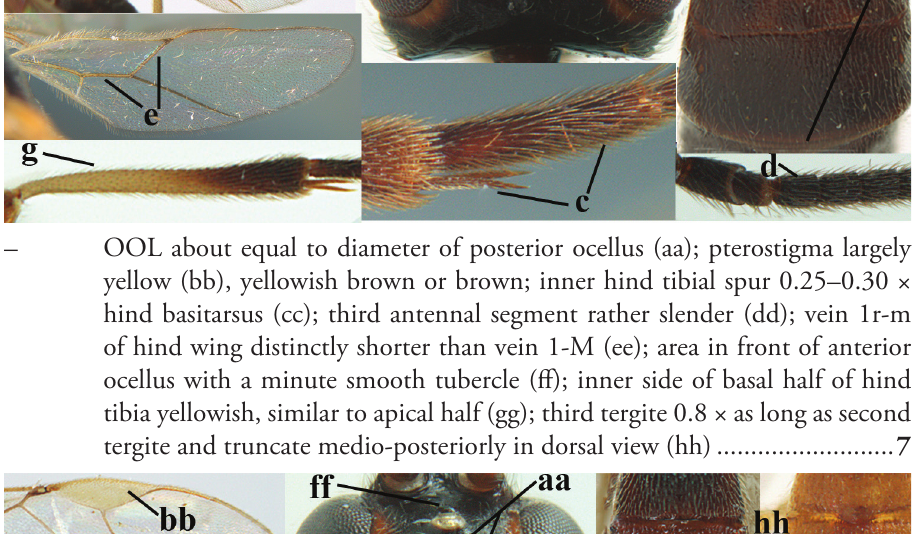
OOL 0.4–0.5 × diameter of posterior ocellus (a); pterostigma dark brown (b); inner hind tibial spur 0.40–0.50 × hind basitarsus (c); third antennal segment robust (d); vein 1r-m of hind wing about as long as vein 1-M (e); area in front of anterior ocellus without tubercle (f); inner side of basal half of hind tibia whitish and contrasting with darker apical half (g), rarely largely dark brown; third tergite about as long as second tergite and curved medio- posteriorly in dorsal view (h) ............. A. albitibia (Herrich-Schäffer,